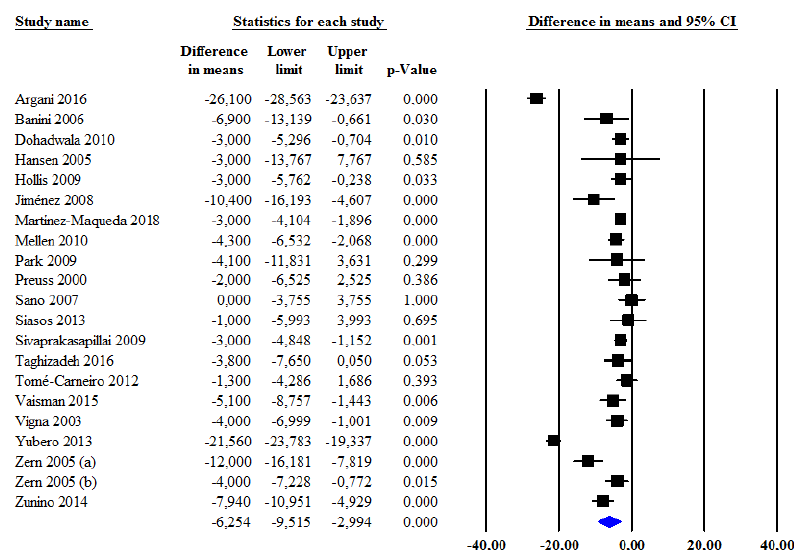
Figure 1. Changes in low-density lipoprotein cholesterol (LDL-C) levels after administration of grape products as compared with controls.